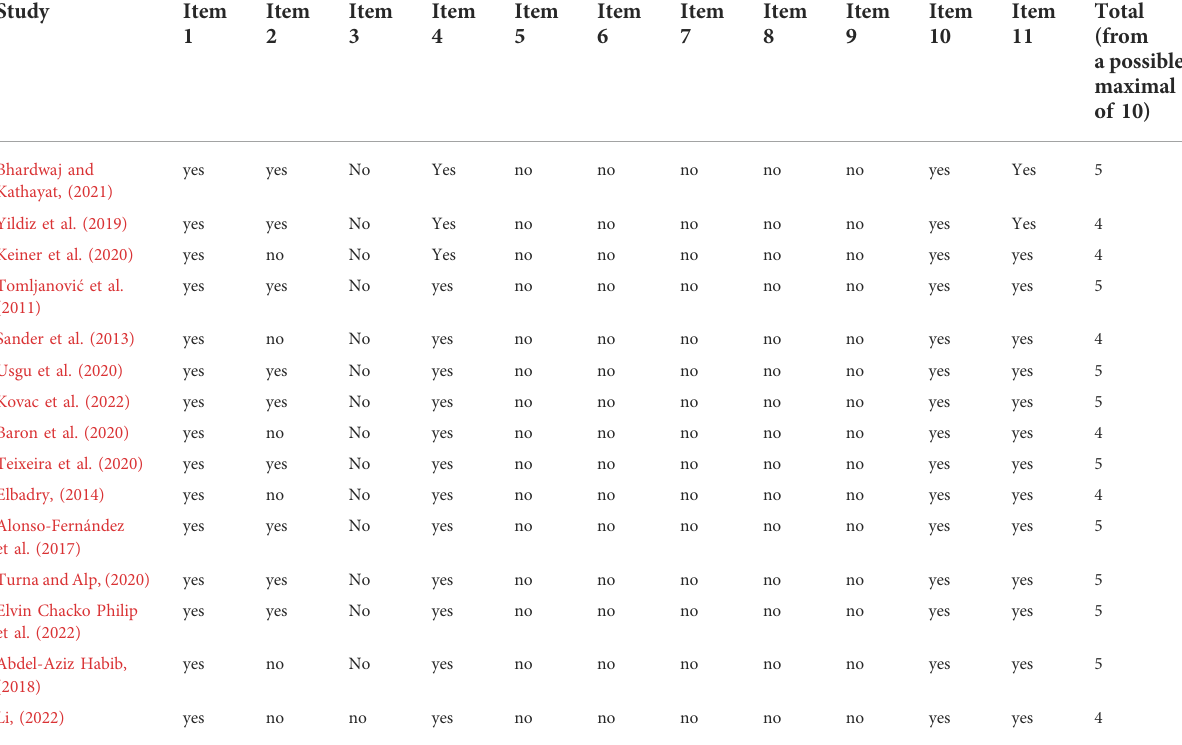
TABLE 1 Physiotherapy evidence database (PEDro) scale ratings a